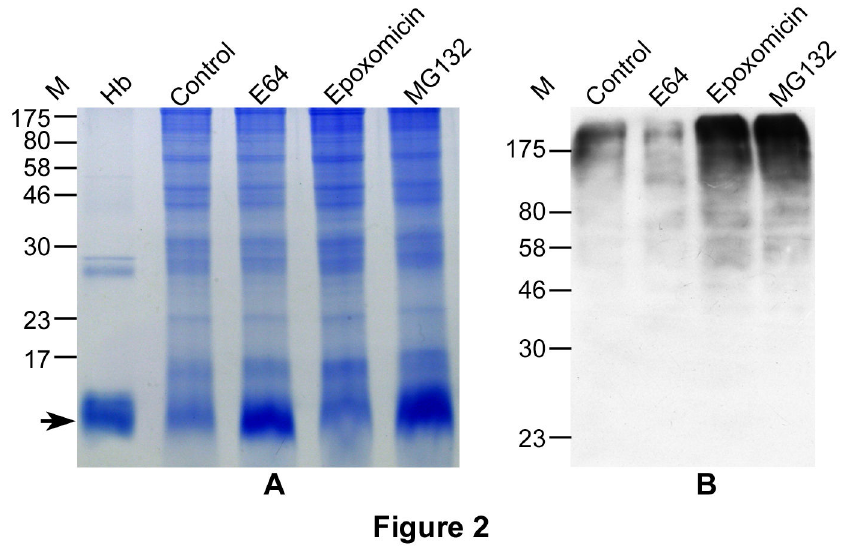
Figure 2. Accumulation of undegraded hemoglobin and ubiquitinated proteins in inhibitor-treated parasites. Cultures containing equal number of early trophozoite stage parasites were grown in the presence of 0.1% DMSO (control) or indicated inhibitors (21.7 µM E64, 0.024 µM epoxomicin, and 0.133 µM MG132; all at concentrations nearly 3 times the IC Parasites were lysed and equal amounts of supernatants were used to assess accumulation of undegraded hemoglobin (A) and ubiquitinated proteins (B) as described in the Materials and Methods section. A . Coomassie-stained SDS-PAGE gel, showing significantly more amount of undegraded hemoglobin (marked with arrow) in parasites treated with E64 and MG132 than control and epoxomicin-treated parasites. B . Western blot using anti-ubiquitin antibodies showed markedly more intense high molecular weight signal in the MG132 and epoxomicin samples than in control and E64 samples, which is indicative of accumulation of ubiquitinated proteins in the MG132 and epoxomicin samples. The experiment was repeated twice, samples from each experiment were analyzed three times for A and two times for B, and the results were reproducible. M, molecular weight in kD; Hb, hemoglobin. doi: